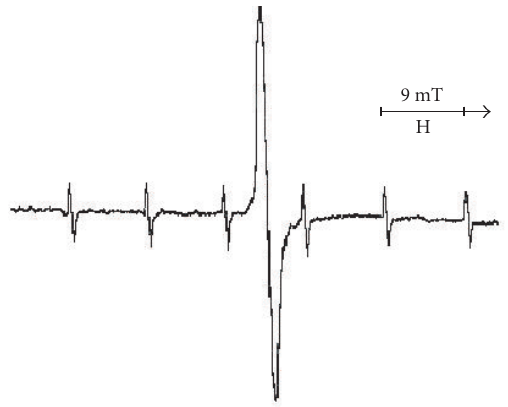
Figure 6: The ESR singlet spectrum ( Δ H = 1 . 74 mT, g -factor 2 . 0047) of irradiated collagen in the presence of ascorbic acid (77K, pH 3 .